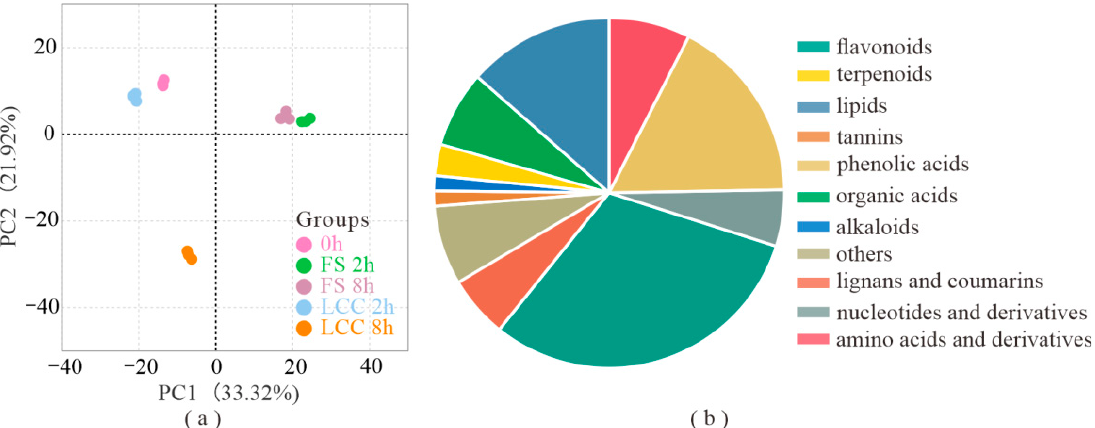
Figure 1. Background of metabolites. ( a ) Principal component analysis (PCA) of metabolome. ( b ) Proportion of different metabolite types in all metabolites.